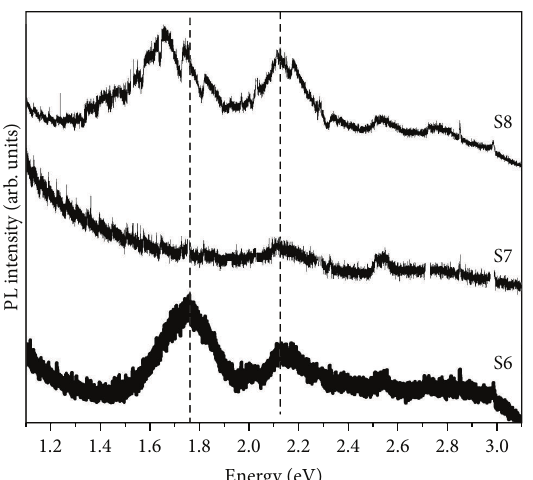
Figure 5: PL spectra of the S7 and S8 𝛼 -CN 𝑥 films deposited on silicon and quartz as substrates, respectively. The included S6 spectrum is included as reference.